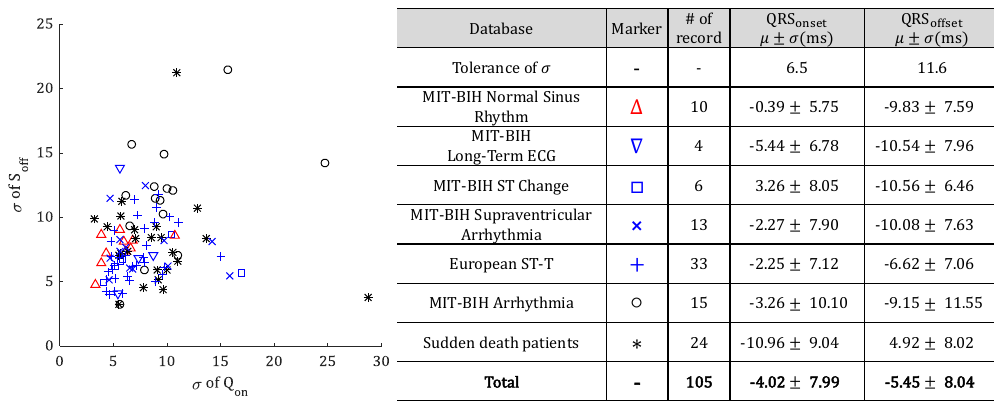
Figure 10. Distribution of standard deviation for